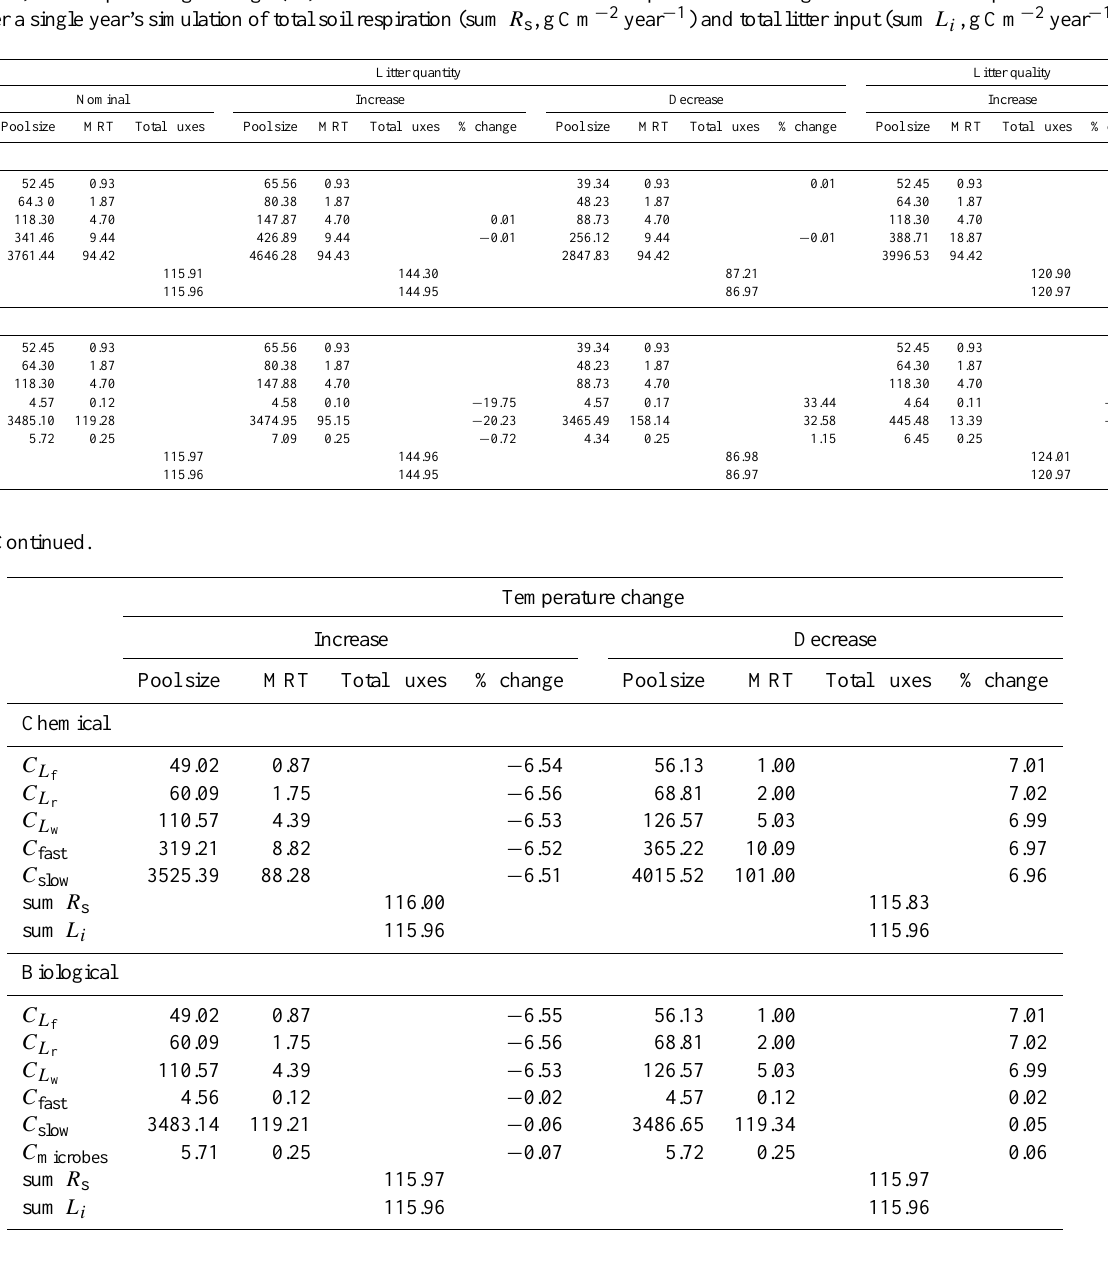
Table 3. Summary of all three experiment and nominal runs for both the biological and chemical models. For each carbon pool, including foliage litter ( C L , gCm − 2 ), root litter ( C L , gCm − 2 ), wood litter ( C L , gCm − 2 ), fast soil carbon ( C fast , gCm − 2 ), slow soil carbon r w f ( C slow , gCm − 2 ) and microbial biomass ( C microbes , gCm − 2 ), the size of the pool at the end of the 1000-year run, the mean residence time (MRT, years) and the percentage change (%) of MRT between the nominal and experiment run are given. The table also presents the sum of